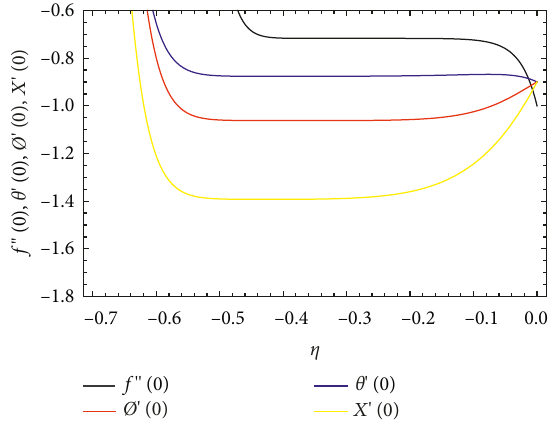
Figure 1: h -curves for ( h